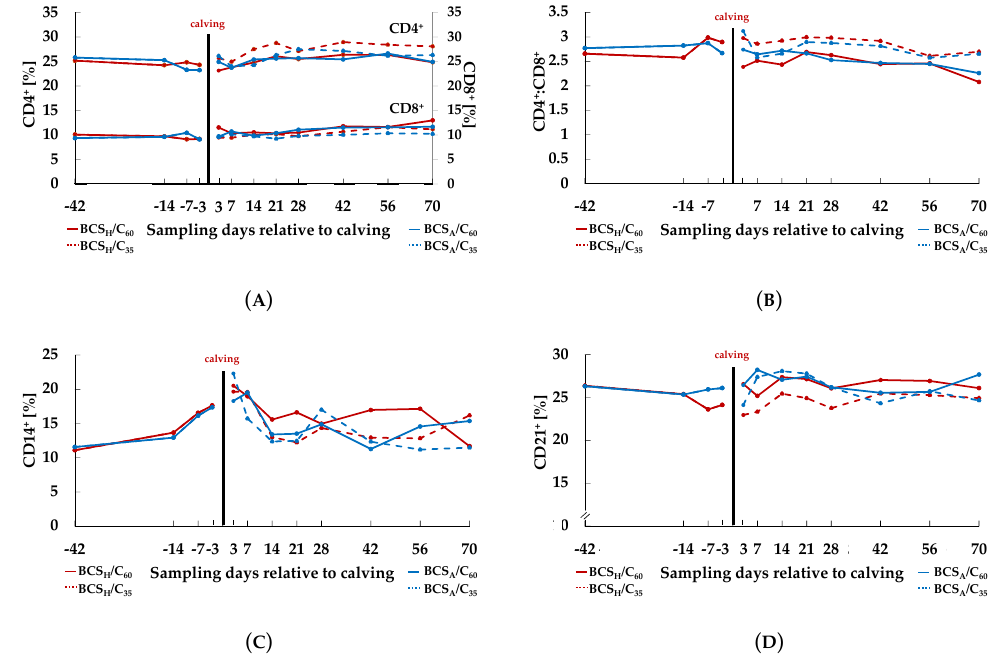
Figure 4. Percentage of CD4 + and CD8 + ( A ), CD4 + :CD8 + -ratio ( B ), as well as percentage of CD14 + ( C ) and CD21 + ( D ) in the course of the experiment. Ante partum , cows were categorized in high body condition score (BCS, BCS H ) and adequate BCS (BCS A ). Post partum , the two groups were subdivided again, each into a group with a concentrate proportion of 60% (C 60 , solid line) in the ration (increasing from 35–60% during the first three weeks after calving) and a group with a concentrate proportion of 35% (C 35 , dashed line) in the ration. Thus, four groups emerged: BCS H / C 60 ( n = 15), BCS H /C 35 ( n = 15), BCS A /C 60 ( n = 15), BCS A /C 35 ( n = 15). Table 3. Model corresponding to Figure 4. p -Values (before Calving) *